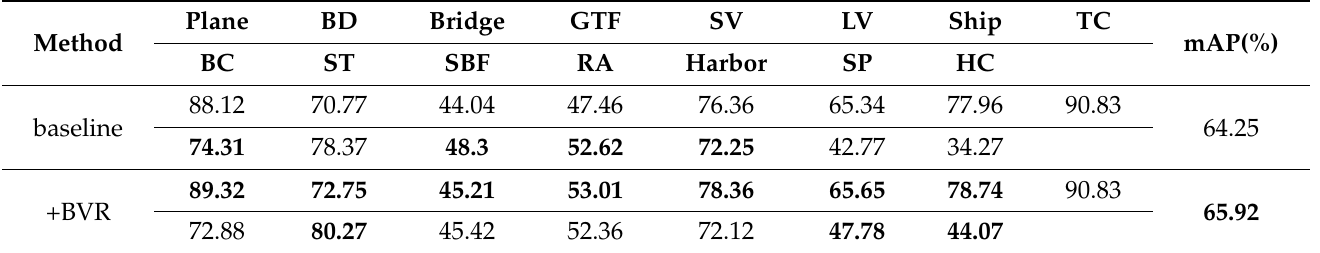
Table 2. Detection accuracy in the ablation study of using BVR module or not with DOTA test dataset. The bold numbers denote the highest values in each